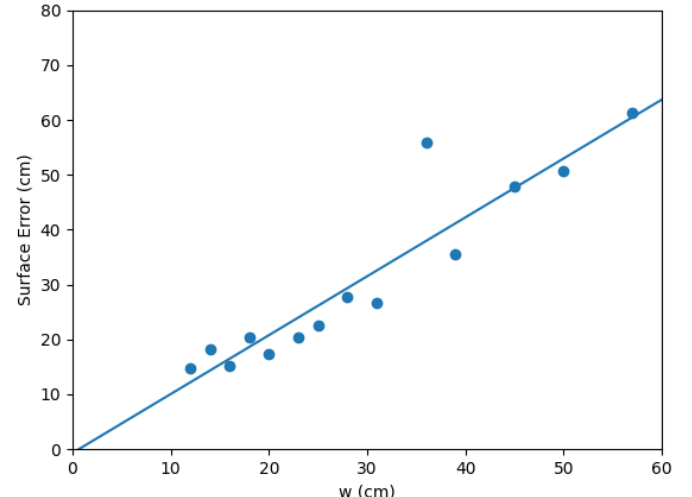
Figure 5. Sensitivity of Surface Error to the voxel size w for case #5 with non-tree objects